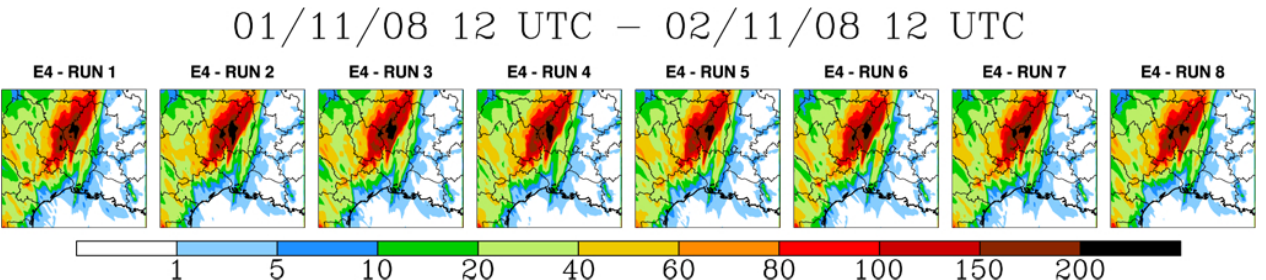
Fig. 7. Same as Fig. 6 but for the C´evennes case and the E4 ensemble. See Fig. 3d. for the reference